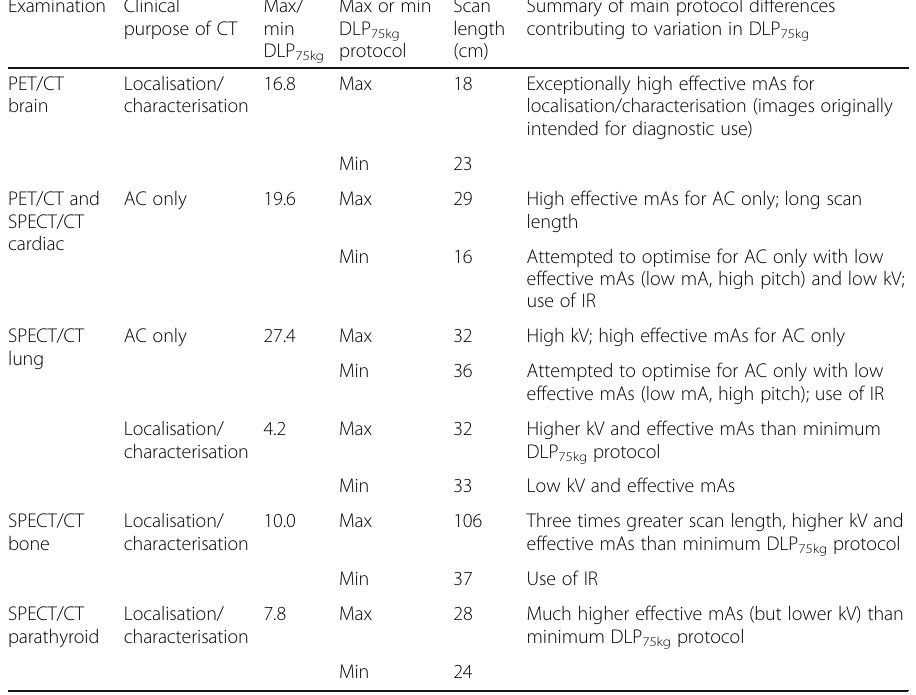
Table 3 Comparison of key protocol settings contributing to dose differences between maximum and minimum DLP 75kg systems